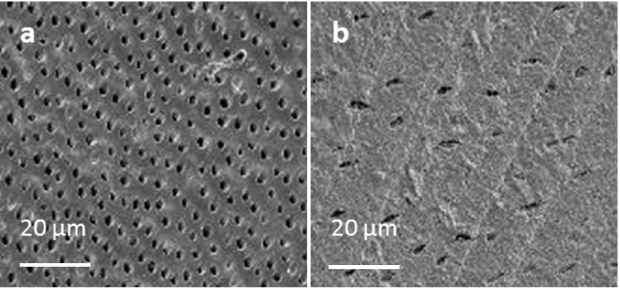
Figure 2. SEM images of ( a ) human dentinal tubules near the pulp; ( b ) tubules in